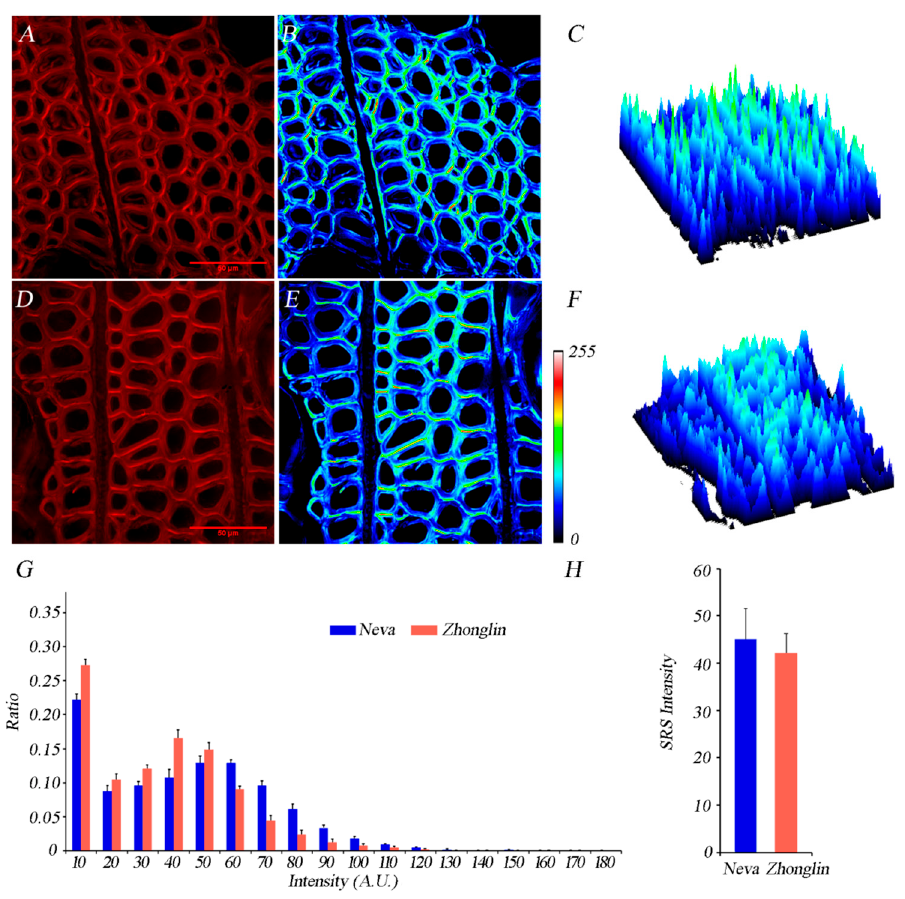
Figure 4. Quantification of cellulose in mature xylem from two black poplar cultivars. ( A , D ) SRS images of P. euramericana ‘Neva’ ( A ) and P. euramericana ‘Zhonglin46’ ( D ) acquired at 1100 cm − 1 , showing the cellulose distribution. Scale bar = 50 µm. ( B , E ) Heat map of ( A ) and ( D ). ( C , F ) The 3D surface plots of ( A ) and ( D ). ( G ) Distribution of fluorescence intensity of the SRS images in ( A ) and ( D ). ( H ) The average intensity of cellulose in xylem cells from the two black poplar cultivars. ns, not significant.